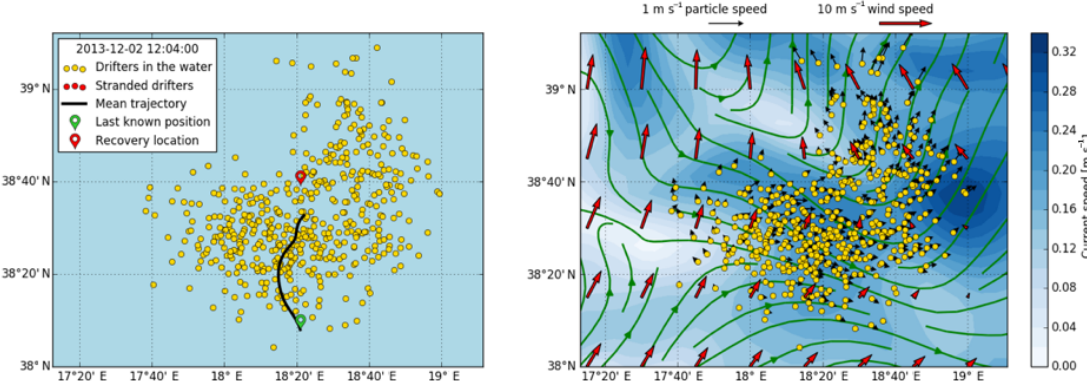
Figure 12. (a) Results of the “migrantship1” simulation done using OCEAN-SAR showing the positions (yellow points) of the particles at the end of the simulation 12:05UTC of 2 December 2013. The red place marker indicates the position in which the ship was found. The green place marker represent the position in which the ship was found and start drifting. The black line shows the mean trajectory of the launched particles. (b) For each position of the drifters (yellow points) little black arrows indicates the direction and speed of their movement. Green streamlines indicate current direction and coloured background shows their magnitude (white is low, blue is high). The wind field is shown by the red vectors.